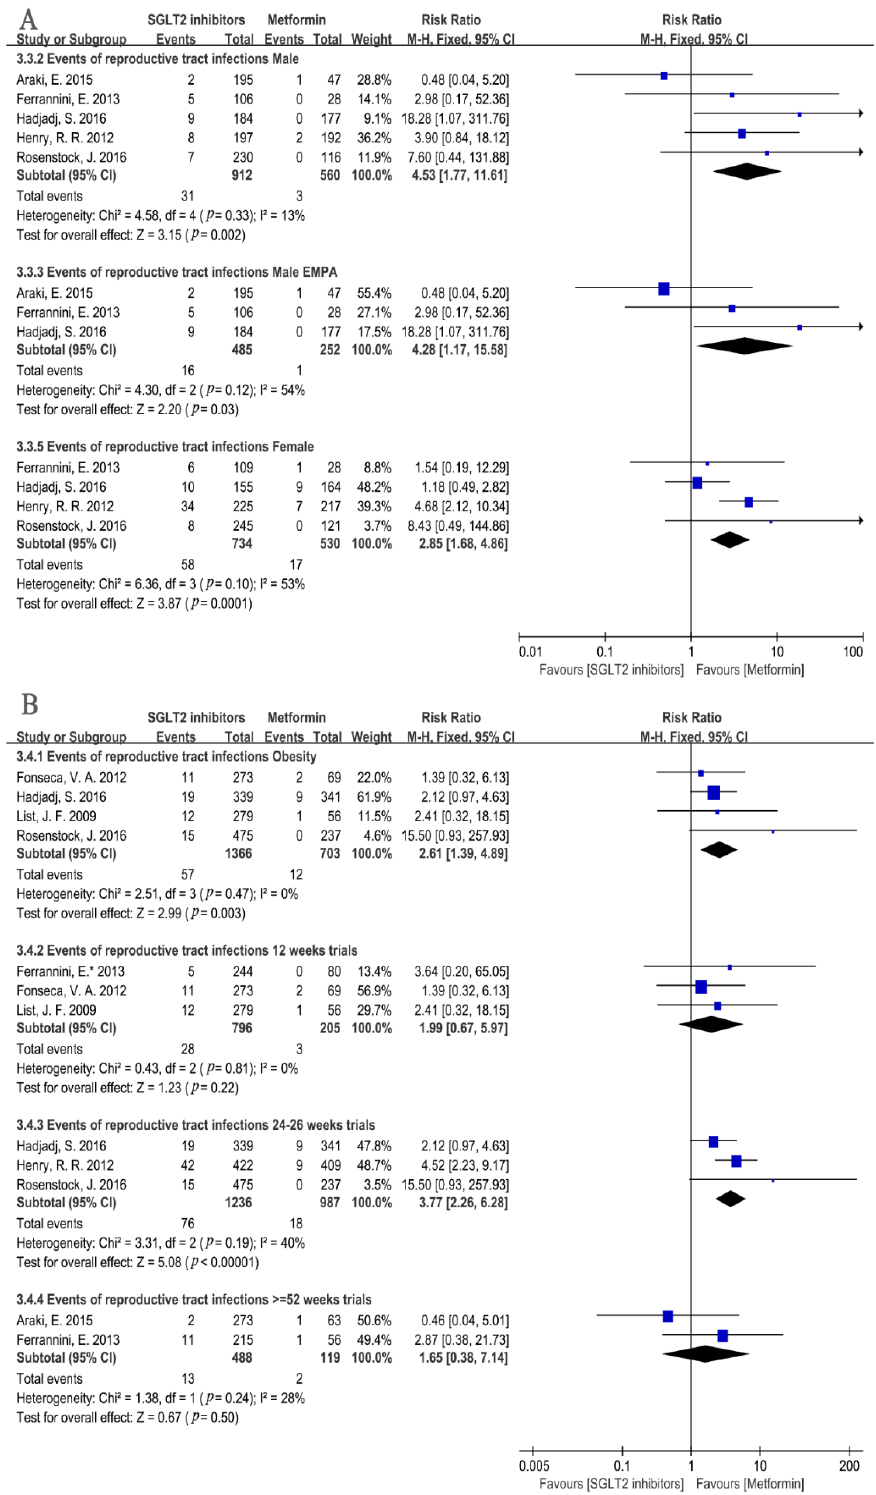
Figure 10. ( A ). Risk of reproductive tract infections with different types and doses of SGLT2i com- pared with that of metformin in male or female patients [20,22–24,29]. ( B ). Risk of reproductive tract infections in SGLT2i group compared with that metformin in obesity patients and risk of reproductive tract infections in patients with different treatment times of SGLT2i at 12 weeks or 24–26 weeks compared with that metformin [20–25,29,31]. EMPA =